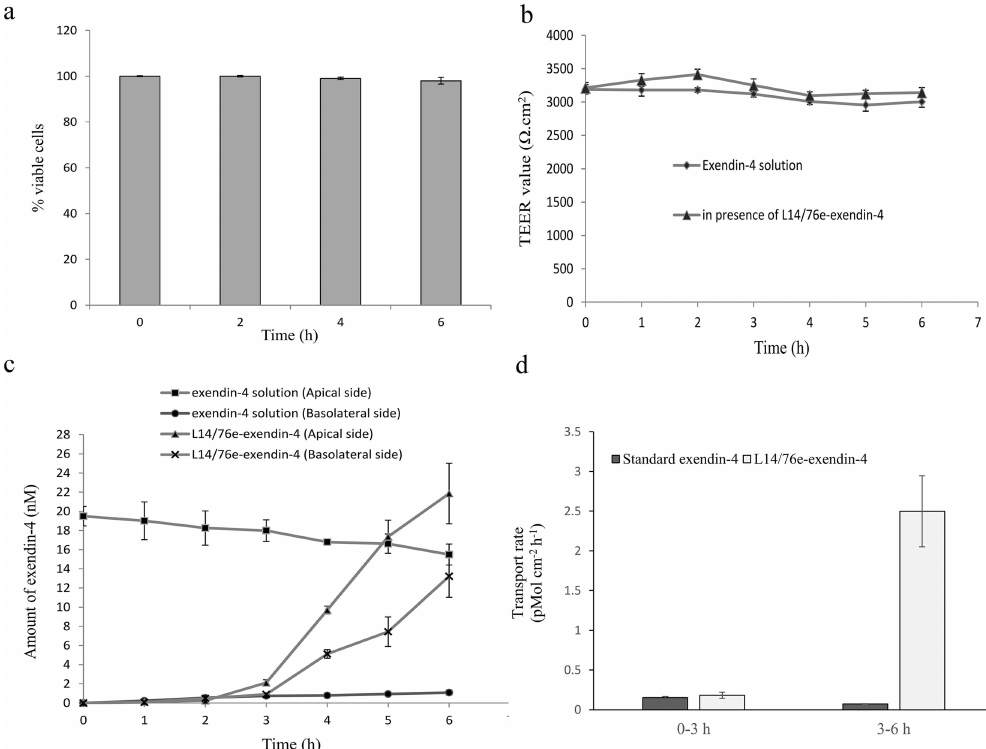
Fig 6. Transport of exendin-4 through Caco-2 cell monolayers. (a) Caco2 cell viabilitywhen co-cultured with strain L14/pMG76e-exendin-4. (b) TEER values of the Caco-2 cell monolayer in the presence of L14/pMG76e- exendin-4or standard exendin-4 solution (control) during the exendin-4transport study (means ± SD, n = 3). L14/ pMG76e-exendin-4 suspension in s-DMEM or standard exendin-4in s-DMEM was added to the apical side of all wells and incubated for 6 h. (c) Transport of exendin-4 across the Caco-2 monolayers(means ± SD, n = 3). Samples from both the apical and basolateral side of the transwellwere taken for the assay of exendin-4 concentration by ELISA (means ± SD, n = 3). (d) Normalized transport rate of exendin-4through Caco-2 monolayers(means ± SD, n =